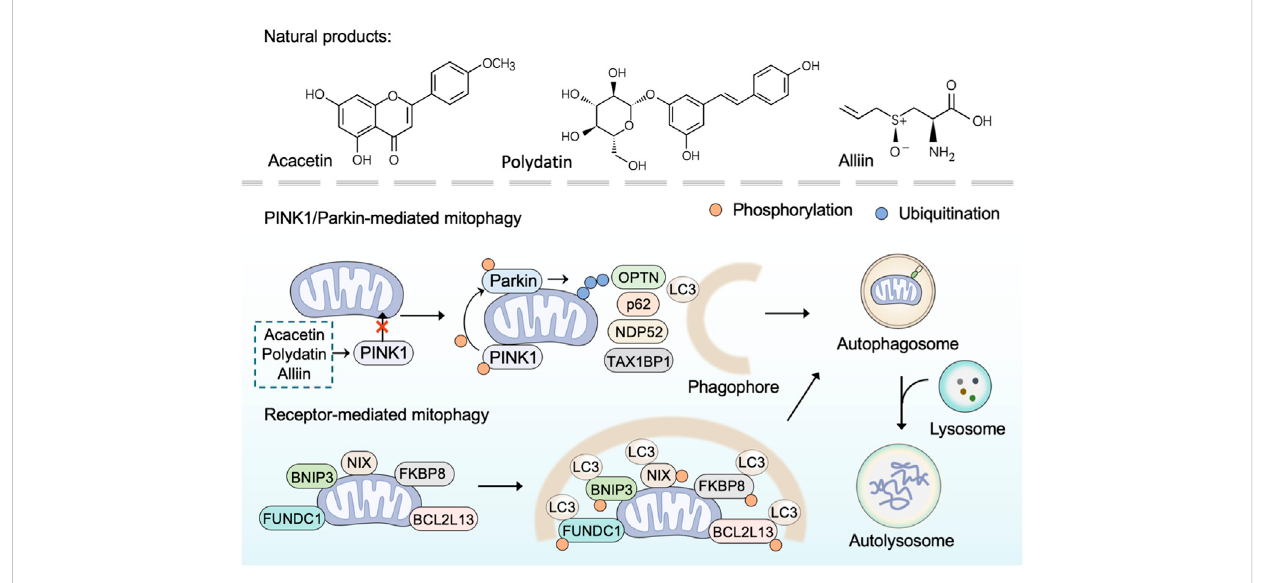
FIGURE 3 Natural products induce mitophagy. PINK1/Parkin-dependent mitophagy is mediated by the accumulated PINK1 through phosphorylating E3- ubiquitin ligase Parkin and activating Parkin-mediated ubiquitination to recruit adaptor proteins (such as p62, OPTN, TAX1BP1, NDP52). The adaptor proteins then bind phosphorylated poly-ubiquitinated chains on mitochondria and LC3, and thus lead to the engulfment of target mitochondria within autophagosome for fi nal degradation Receptor-mediated mitophagy is mediated by receptor proteins (BNIP3, NIX, FUNDC1, BCL2L13, FKBP8) throughbindingLC3directlyinaubiquitin-independentmannertobringtogetherautophagosomalmembranesandmitochondriaforthedegradationof target mitochondria. Natural products such as polydatin, acacetin, and alliin induce mitophagy through the PINK 1/Parkin